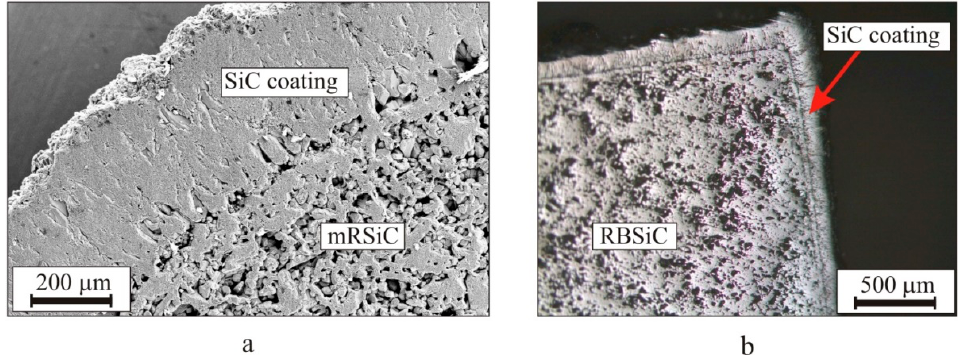
Figure 14. Protective SiC coating on recrystallized ( a ) and reaction-bonded ( b ) SiC.